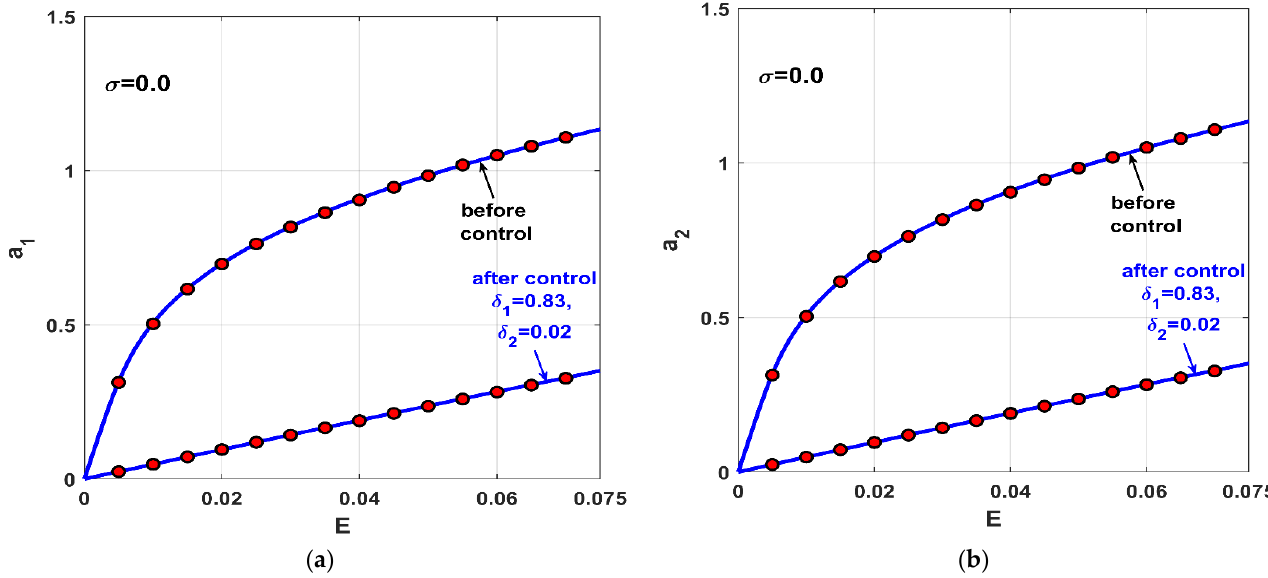
Figure 22. 𝐸 − response curve of the studied Jeffcott rotor system before control and after optimal control (i.e., 𝛿 (cid:2869) = 0.83 and 𝛿 (cid:2870) = 0.02 ): ( a ) oscillation amplitude 𝑎 (cid:2869) versus 𝐸 when 𝜎 = 0 , and ( b ) oscillation amplitude 𝑎 (cid:2870) versus 𝐸 when 𝜎 = 0 .